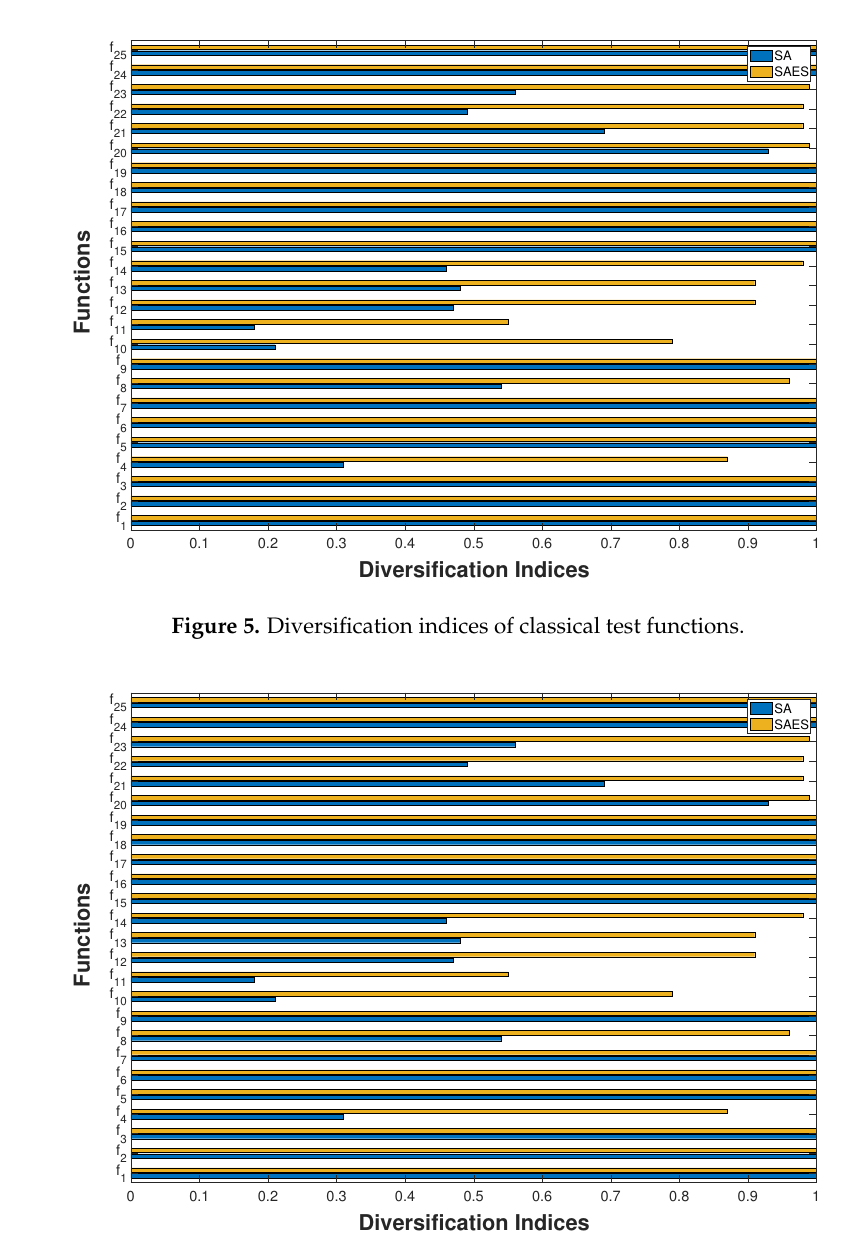
Figure 6. Diversification indices of classical hard